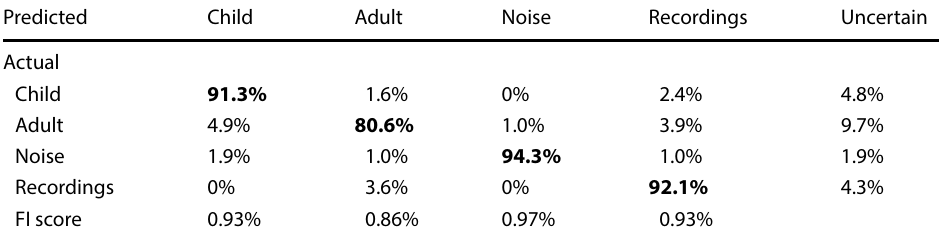
Best performing methods are shown in